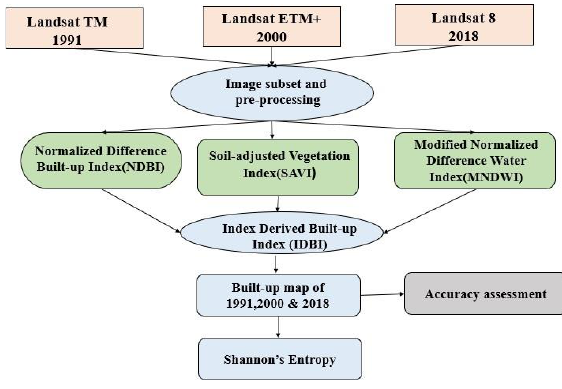
Figure 3: Flow chart of the methodology